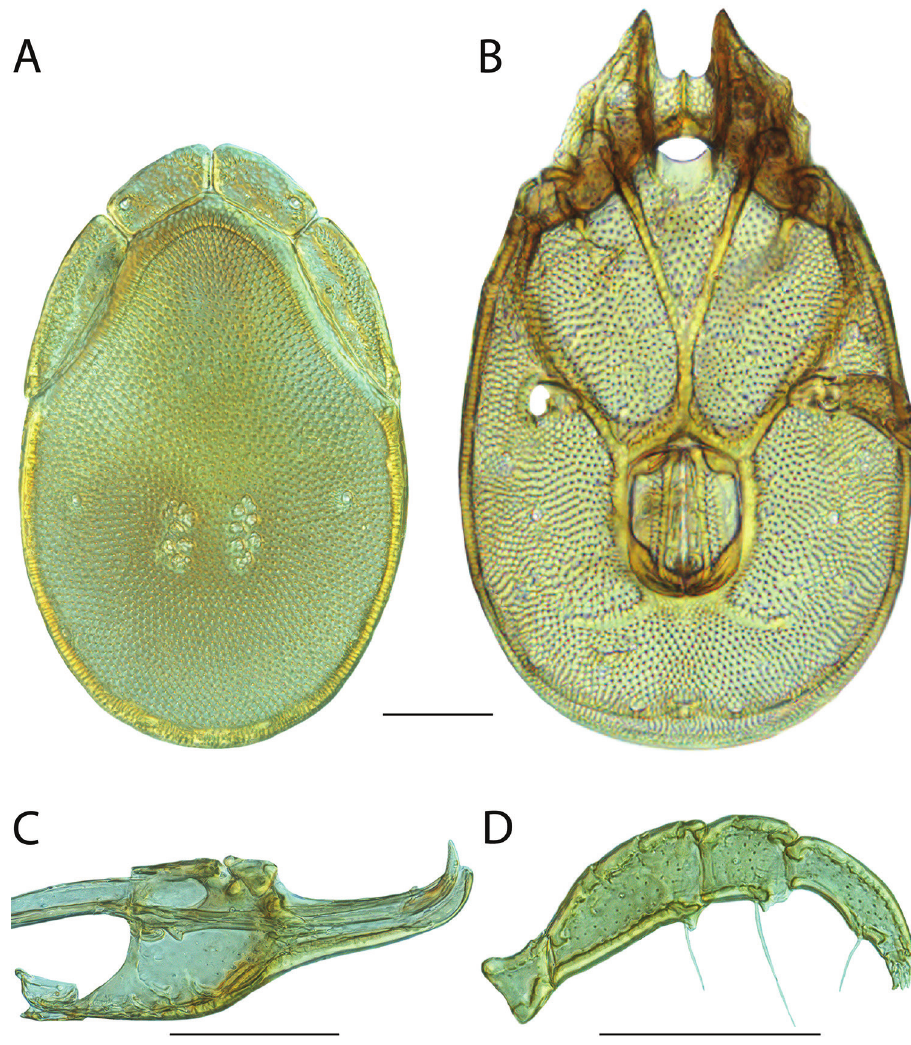
Figure 219. Torrenticola reduncarostra sp. n. male: A dorsal plates B venter (legs removed) C subcapitulum D pedipalp (setae not accurately depicted). Scale = 100